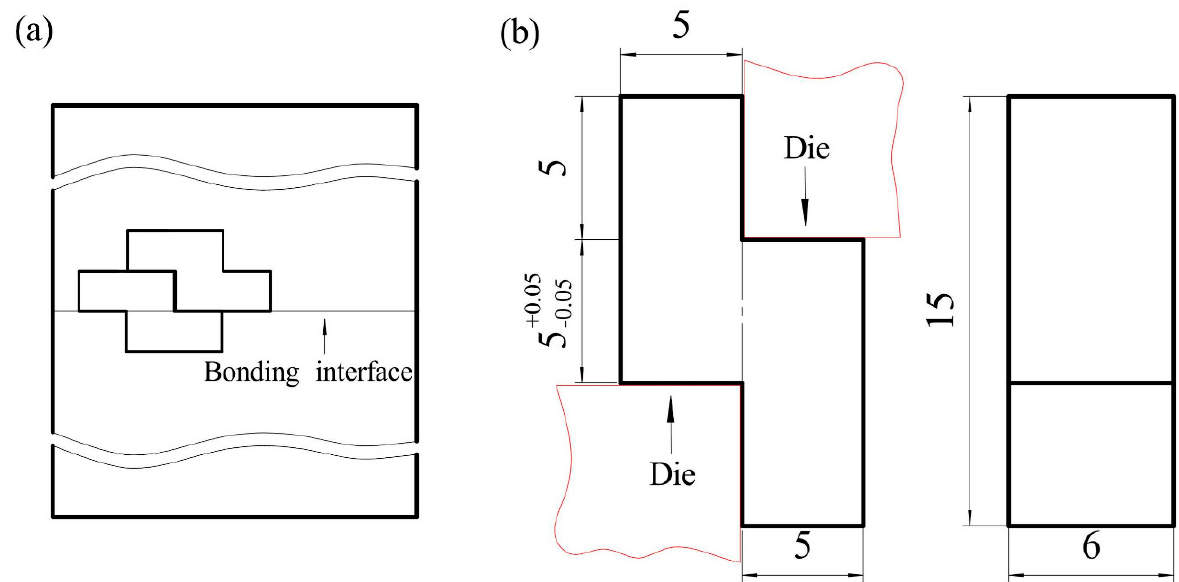
Figure 4. Location ( a ) and dimension ( b ) of the shear samples cut from the bond and base alloy. (Unit: mm).